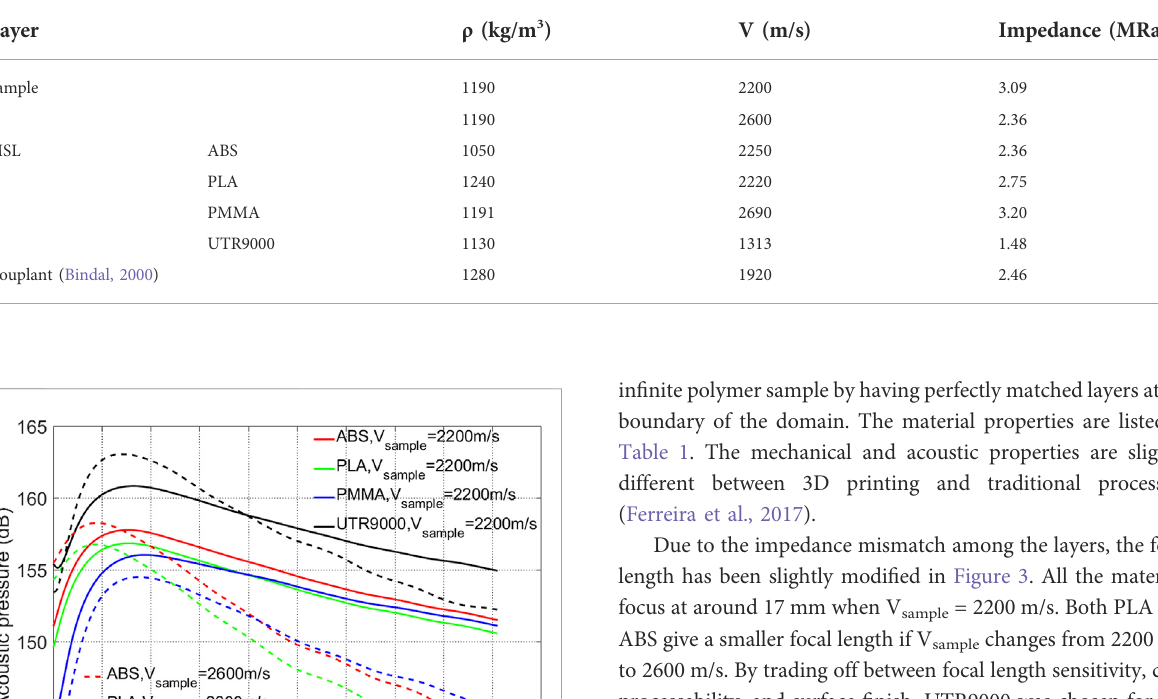
TABLE 1 Acoustic properties of materials during simulation.